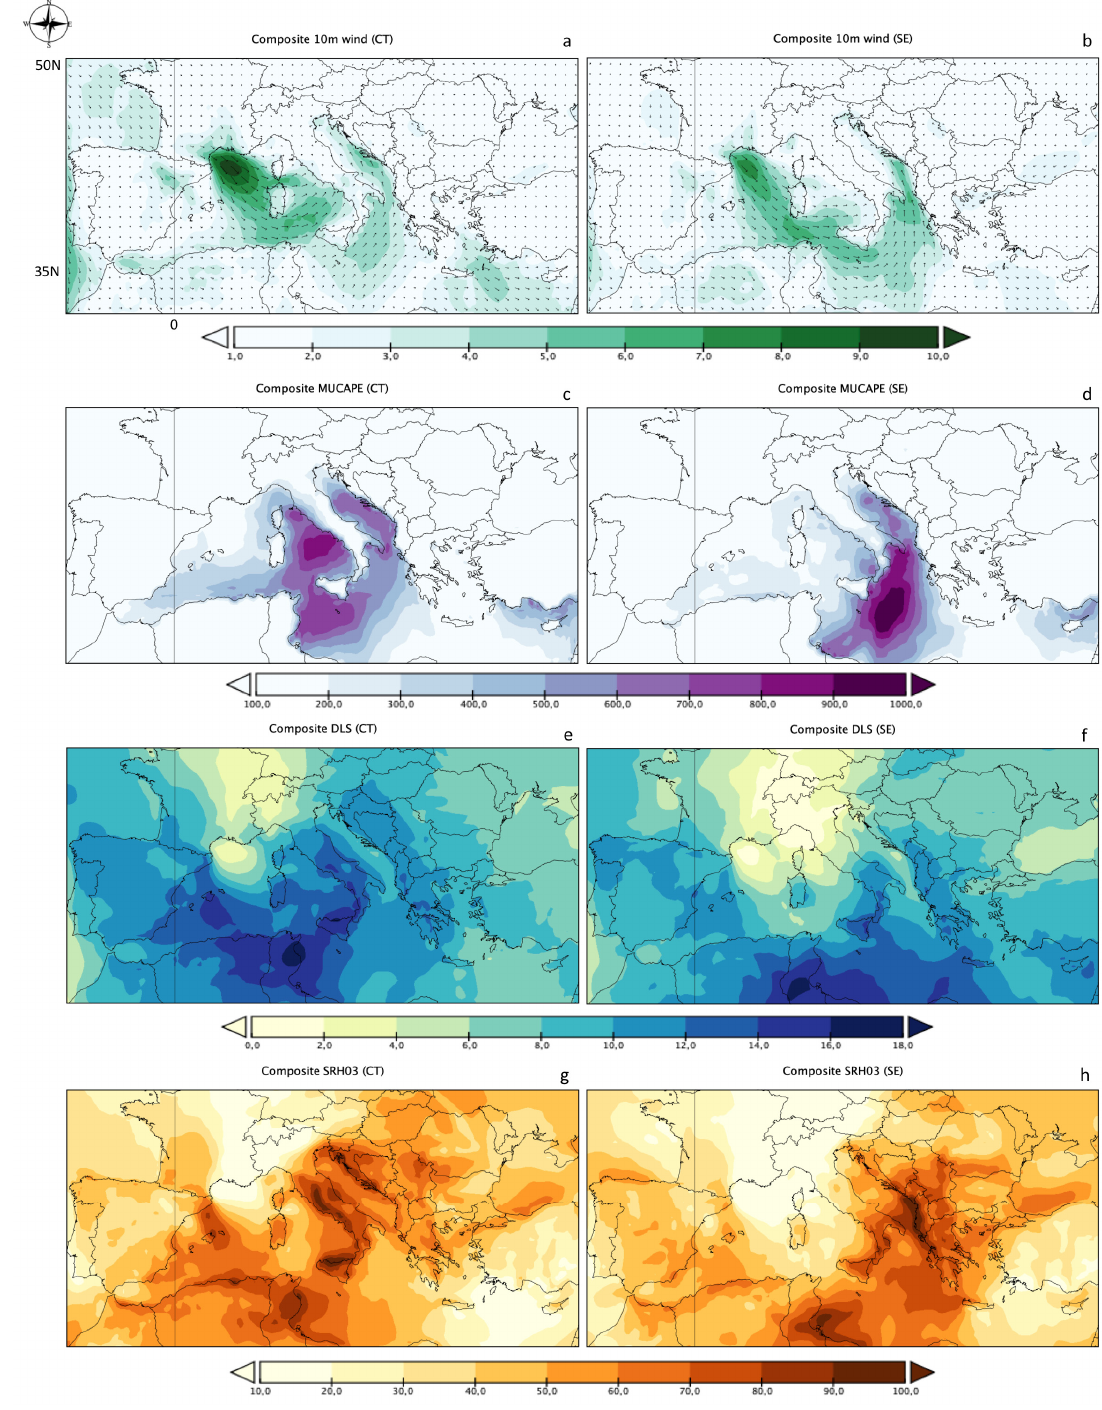
Figure 5. Average anomalies of the ERA5 fields of: geopotential height at 500 hPa [m] ( a , b ), mean sea level pressure [hPa] ( c , d ), temperature at 850 hPa [K] ( e , f ), and sea surface temperature [K] ( g , h ). Left (right) panels refer to CT (SE)